Question: What visual encoding does this figure use to show its data?
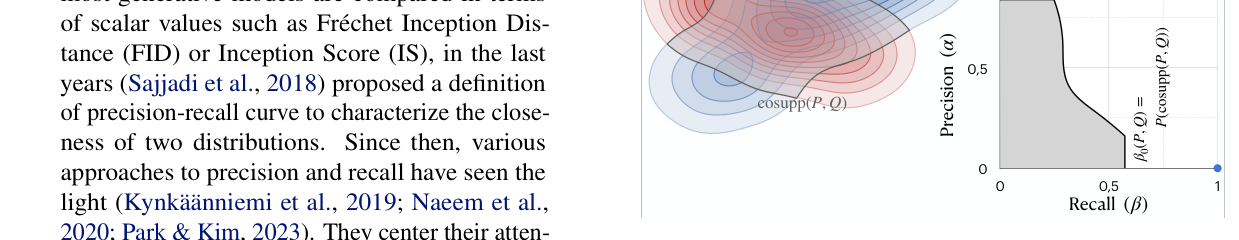
Answer: line